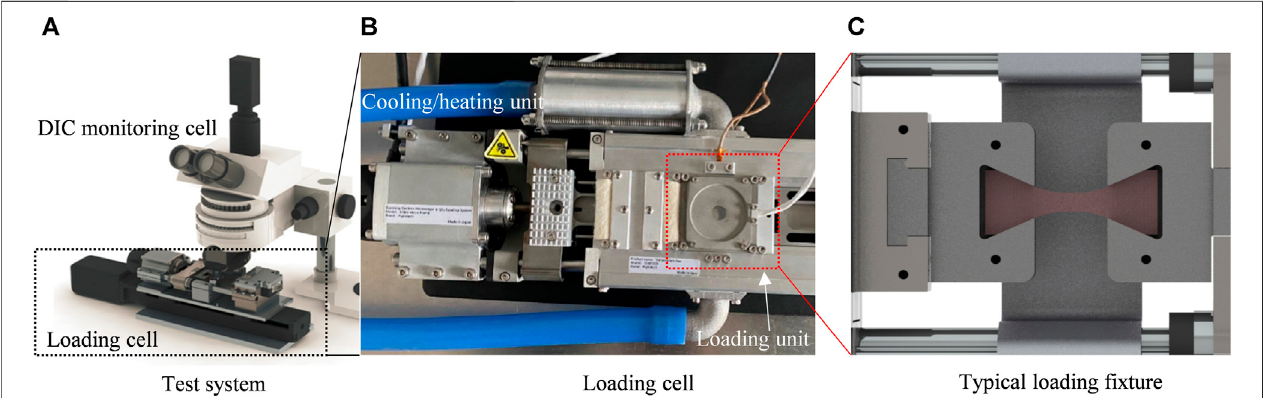
FIGURE 3 | Loading device employed in this